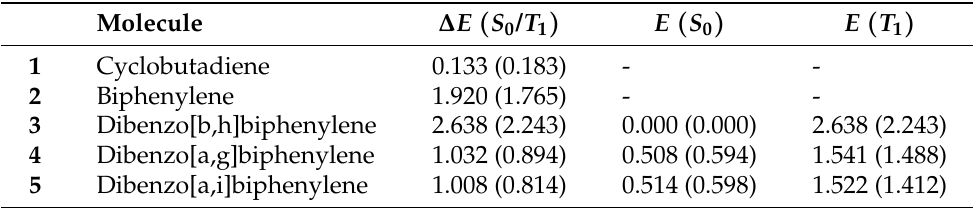
Table 2. Adiabatic excitation energies to the first triplet state ∆ E ( S 0 / T 1 ) and total energies E ( S 0 ) and E ( T 1 ) , referenced against the S 0 energy of 3 , for the molecules studied computed at the DFT/TPSSh level of theory (CASPT values in parentheses). All energies are given in